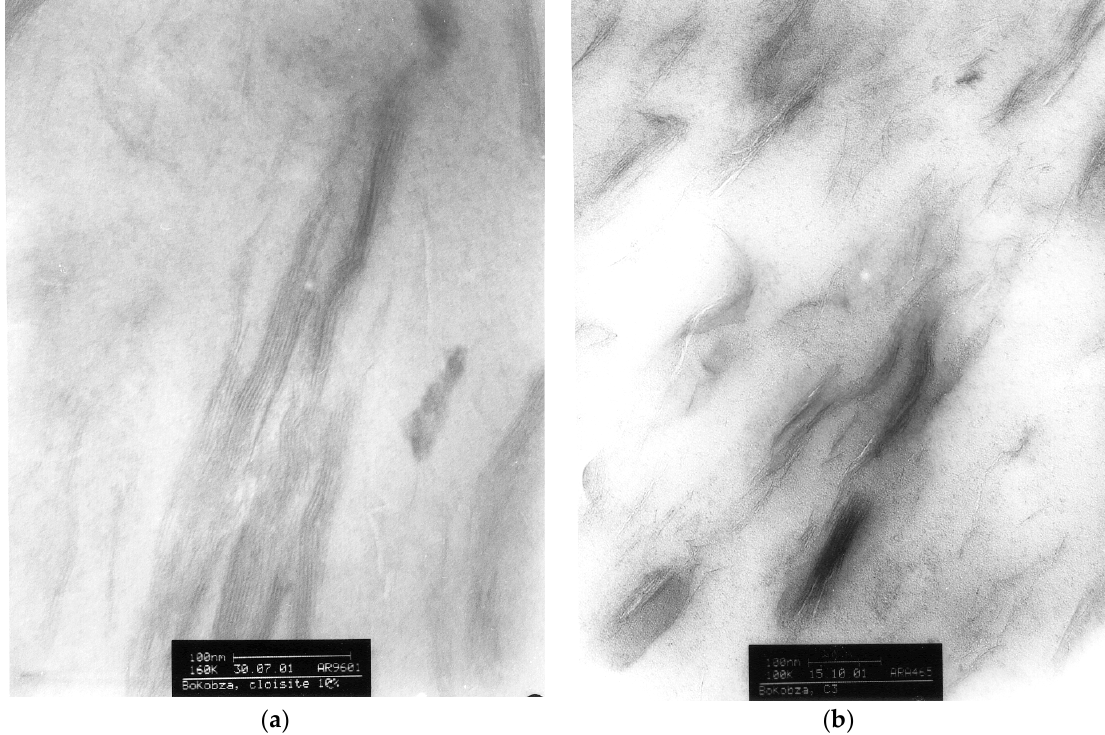
Figure 4. TEM micrographs of natural rubber filled with 10 wt % of clay: ( a ) is for unmodified clay (Reproduced with permission from [43]. Copyright ACS Publications, 2002.) and ( b ) is for organomodified clay. The higher horizontal bar corresponds to 100 nm.